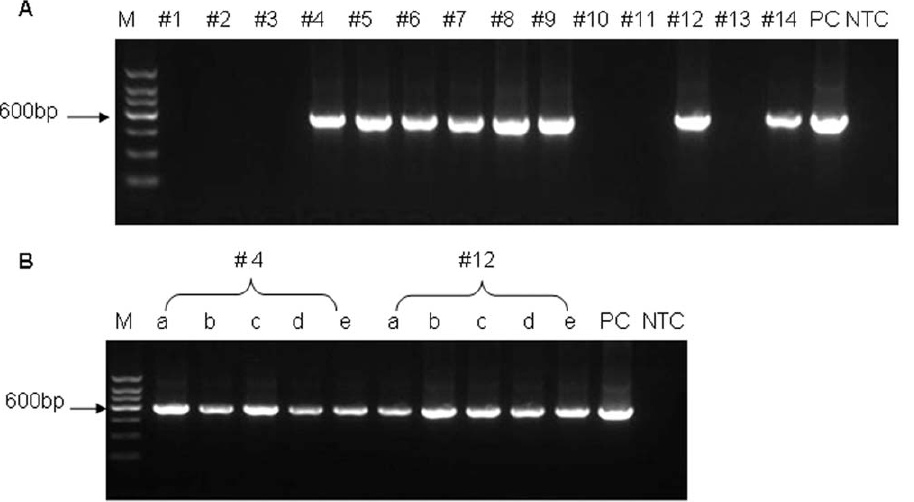
Figure 1. Analysis of EGFP-lentivirus transgene integration in transgenic sheep. (A) Amplification of EGFP transgene from genomic DNA extracted from tail tips of newborn lambs. # 1–14: transgenic newborn lambs. (B) Amplification of EGFP transgene from tissues of # 4 and # 12 anatomized lambs. a-e: heart, liver, spleen, lung and kidney, respectively. Amplicons are 604 bp fragments spanning CMV promoter and EGFP sequences. M, DNA marker; PC, pLEX-EGFP vector as positive control; NTC, non-transgenic sheep DNA control. doi:10.1371/journal.pone.0054614.g001 Eco RI (TAKARA) or double-digested with SfiI and HpaI (TAKARA). After precipitation with alcohol, 10 m g digested Integration numbers of transgene were determined by Southern DNA was separated on 0.7% agarose gel with 25 volt electropho- blotting analysis. Genomic DNA from tail tips was extracted by resis overnight. Blotting was carried on by vacuum transfer to means of standard phenol-chloroform extraction and digested with